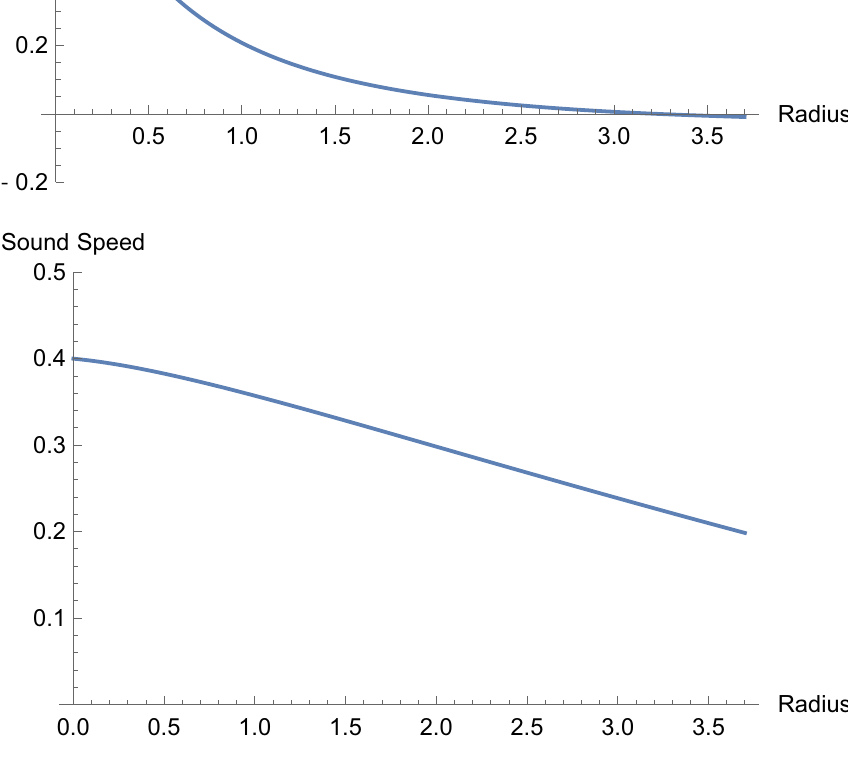
Fig. 3 Square of sound speed dp versus the radial variable d ρ